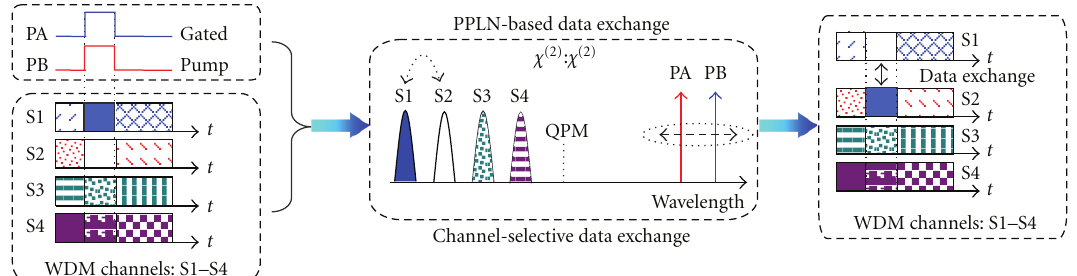
Figure 4: Concept of single-PPLN-based time- and channel-selective data exchange between WDM